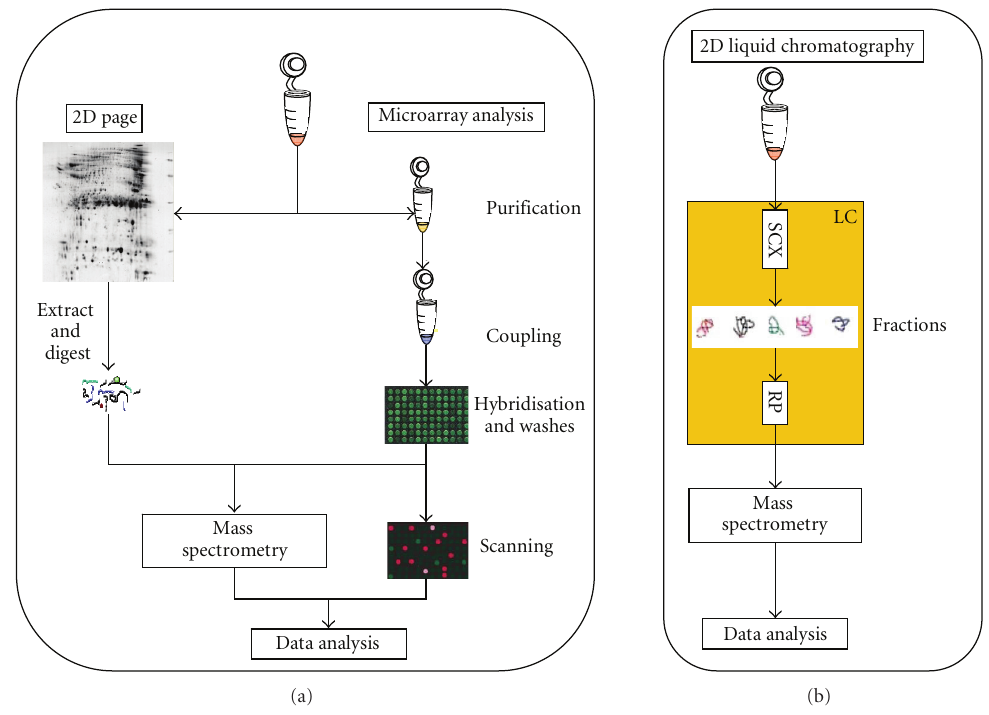
Figure 4: (a) Proteins from mixtures are analysed using 2D PAGE followed by mass spectrometry. The identification of proteins is from the spectra produced from the peptides of the digested proteins which provide a unique fingerprint from the peptides. Protein microarrays consist of di ff erent protein binding molecules, for example, antibodies at separate locations on a chip made from glass or silicone to capture molecules to detect proteins from cell lysate solutions. The proteins can be visualised using a fluorometric or colorimetric analysis or the spots can be analysed by mass spectrometry. (b) Multidimensional liquid chromatography mass spectrometry (LC-MS) involves digestion of a complex protein sample initially using a strong cation exchange (SCX) column. The resulting peptides are separated by LC into fractions. The resulting fractions are separated further using a reversed-phase (RP) column and characterized by mass spectrometry using shotgun sequencing of the